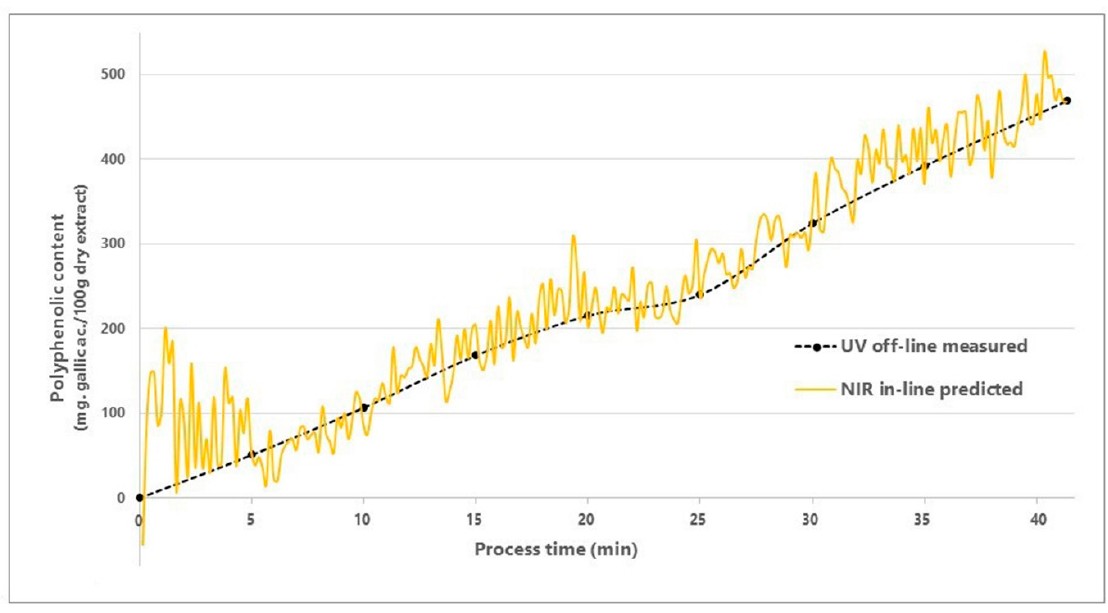
Figure 4. UV-Vis off-line measured vs. NIR in-line predicted total polyphenolic content.